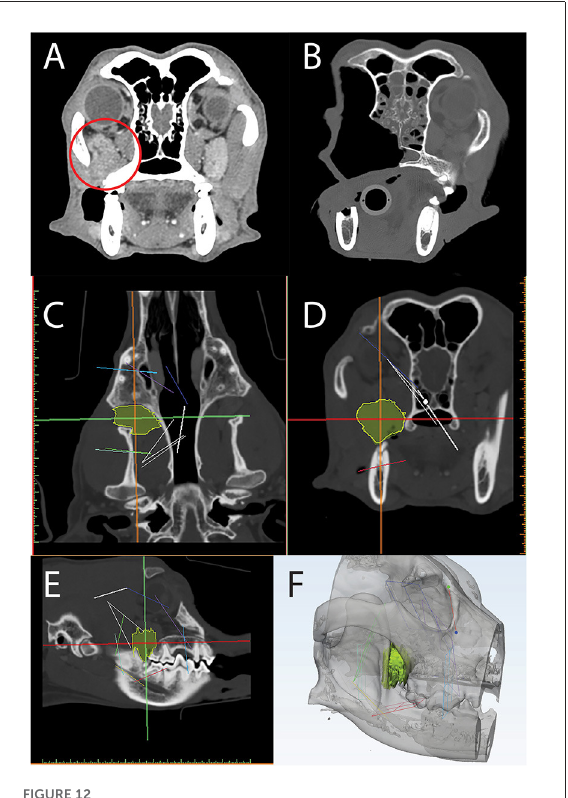
FIGURE12 Axial CT of a post-contrast image study depicting a caudal maxillary neoplasm in case 3 (A) . Panels C-F are computer screenshots depicting the segmentation of the neoplasm in yellow (C–E) and VSP on a 3D computer model (F) . The excised segment can be appreciated in the immediate post-operative axial CT image (B) . Note the medial orbitectomy plane is consistent with virtual surgical